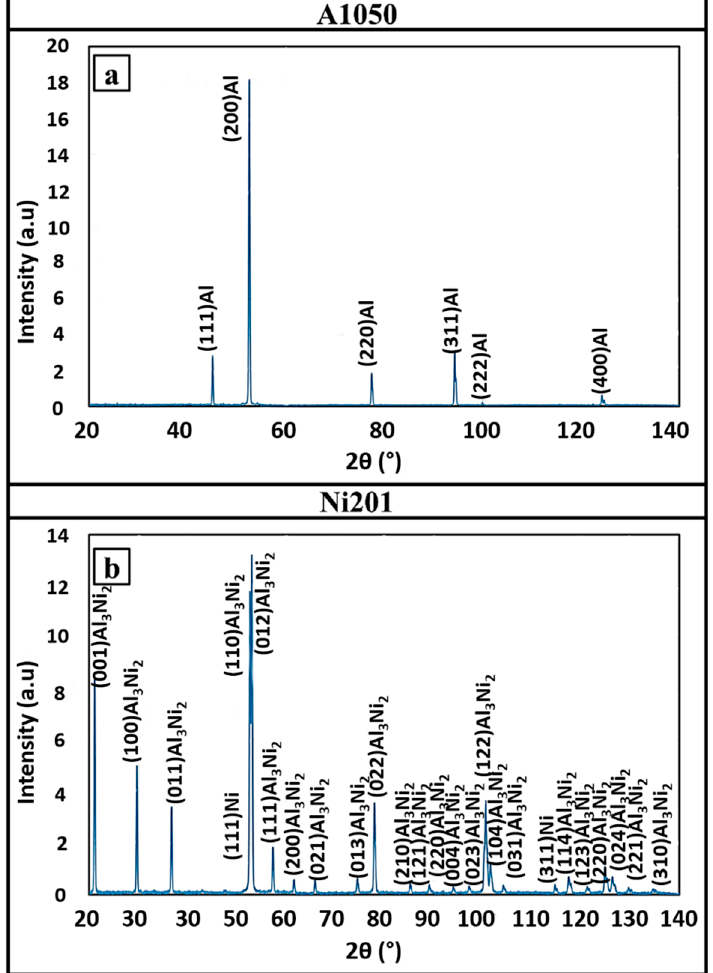
Figure 12. XRD patterns taken from the fracture surfaces of A1050 ( a ) and Ni201 ( b ) after the disintegration of Ni201/A1050 clad manufactured at V d = 2000 m/s followed by annealing at 500 °C for 168 h after disintegration.